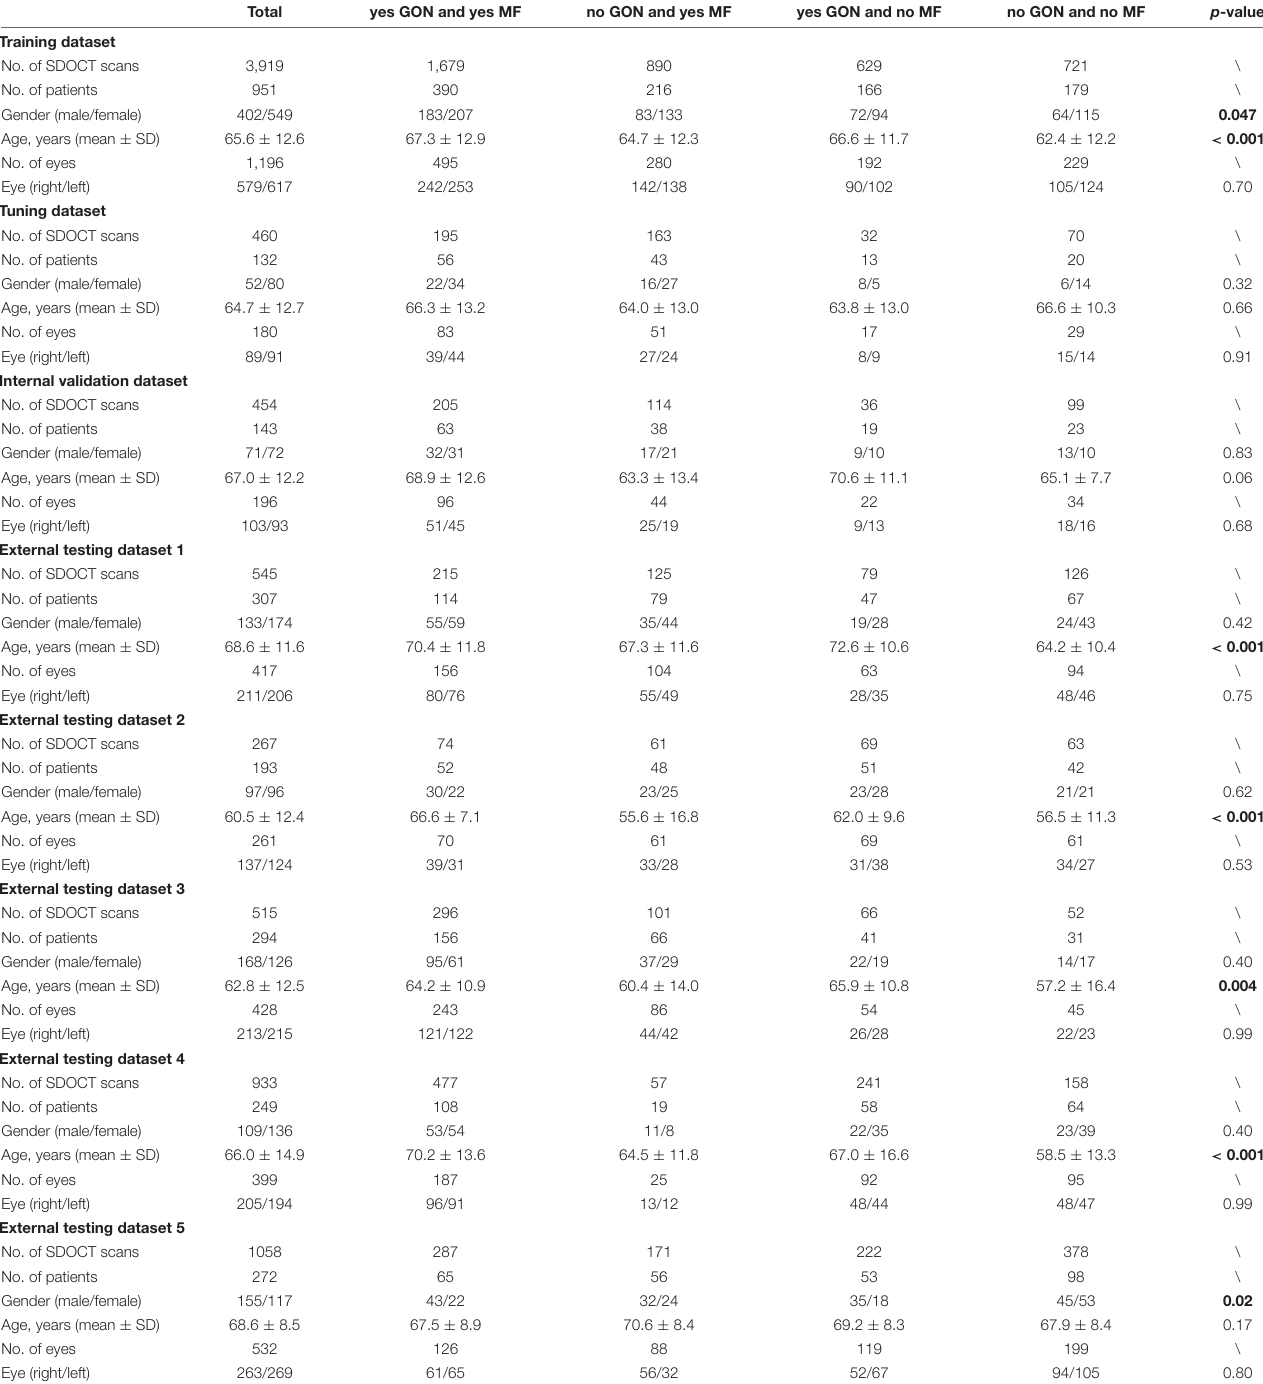
TABLE 1 | Summary of the study subjects and data distribution.